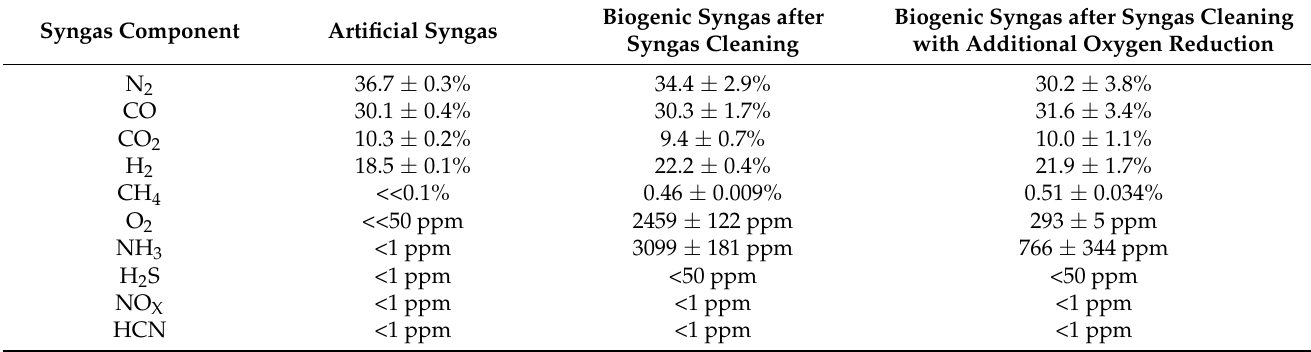
Table 1. Composition of artificial syngas and real syngas from entrained flow gasification of biogenic residues (torrefied wood, TorrCoal) without reduction of oxygen, and with reduction of oxygen by a plug flow reactor (inner diameter 10 mm; length 1000 mm) with 30 g Actisorb O3 and 10 g silica beads at a temperature of 50 ◦